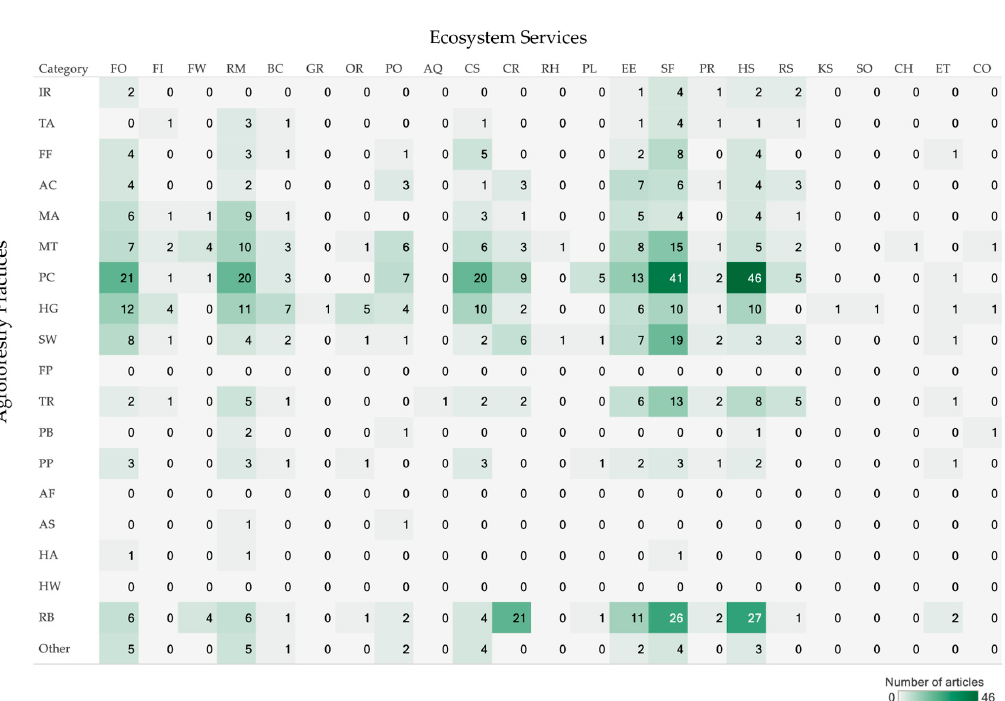
Figure 8. The linkage between agroforestry practices and ecosystem services in the 1990s. Note: The darker the color of the cells, the higher the frequency of articles. Water 2020 , 12 , x FOR PEER REVIEW 3 of 3